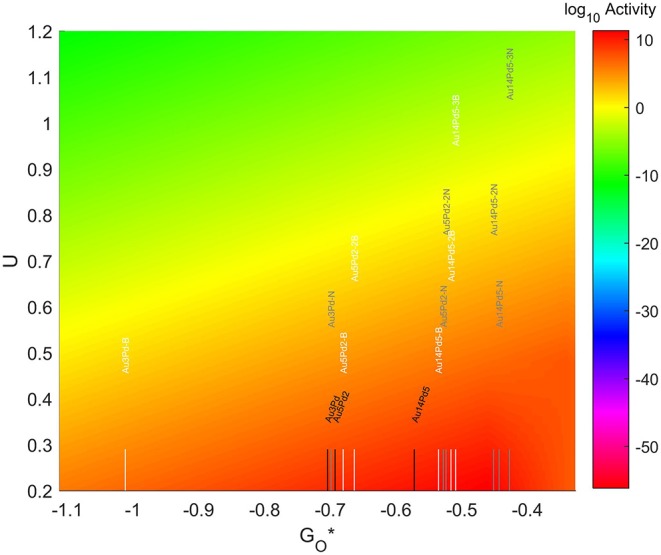
Volcano plot for ORR activity of Au-Pd 4-atom, 7-atom, and 19-atom TMNP-doped-MDG. 4/7/19 atom systems are Au3Pd1, Au5Pd2, and Au14Pd5, respectively.